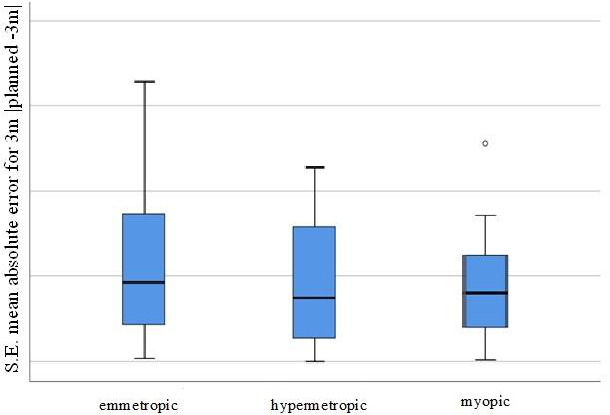
Figure 2. Visual representation of the MAE for the individual patient groups (SE mean absolute error for 3 m, planned −3 m, for the emmetropic/hypermetropic/myopic groups). When analysing the values of the absolute errors after the procedures, no differences were found between the three groups (hypermetropic, emmetropic, and myopic) at 3 weeks and at 3 months. Further, there were no differences between the absolute errors for the three-week and the three-month periods in each of the three groups (hypermetropic, emmetropic, and myopic) (all p values were >0.1). The SE mean absolute errors (3 months vs. planning) were converted in two ways: